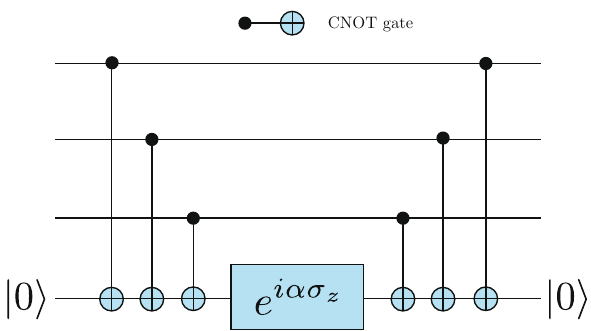
Fig. 1 Illustrationofacircuitimplementingtheunitarytransformation (cid:4) (cid:5) σ i i α exp z i